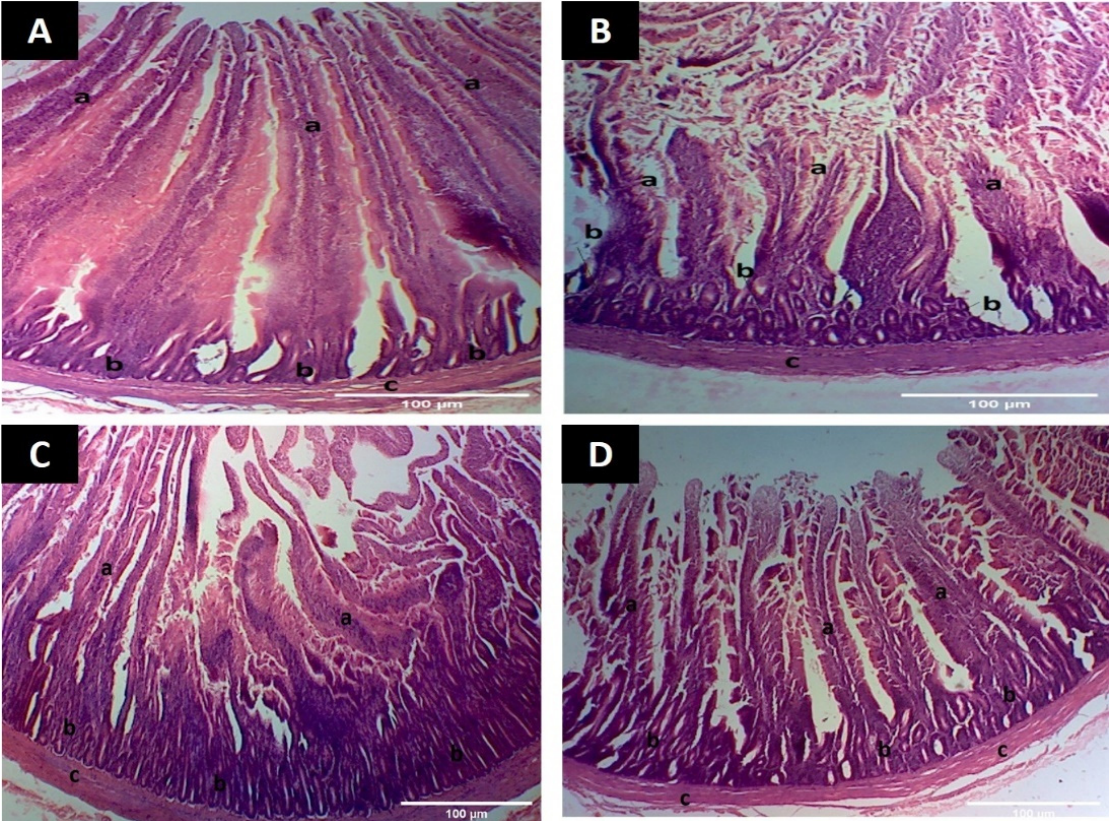
Figure 5. Photomicrographs of jejunum showing microscopic changes ( A ) Intestine from group A showing (a) developed villi having intact epithelium (b) goblet cells (c) submucosa (H&E staining 100×) ( B ) Intestine from group B showing (a) damaged villi with disrupted epithelium (b) fewer goblet cells (c) submucosa (H&E staining 100×) ( C ) Intestine from group C showing (a) developed villi (b) goblet cells (c) submucosa (H&E staining 100×) ( D ) Intestine from group D showing (a) villi with damaged epithelium at few places (b) goblet cells (c) submucosa (H&E staining 100×).